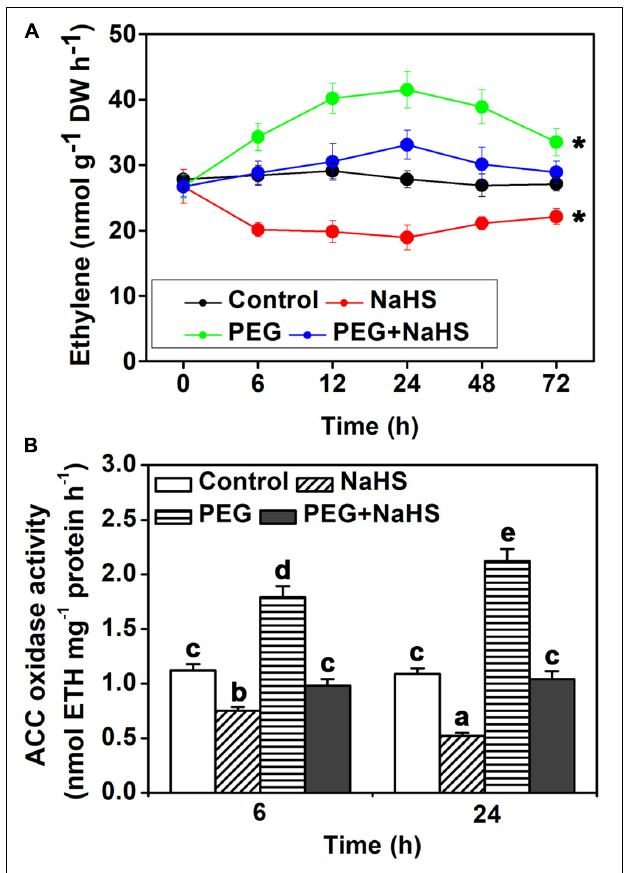
FIGURE 3 | Analysis of endogenous ethylene content and ACO activity. (A) Time curve of ethylene content. (B) ACO activity. Two-week-old tomato seedlings were supplied with 25% PEG and 200 µ M NaHS for 6–72 h, and then endogenous ethylene content and ACO activity were measured in leaves. Mean values ± SE are calculated from three replicates. Within each set of experiments, bars with different letters are significant different (Student’s t -test, ∗ P < 0.05; Duncan’s multiple range tests, P <